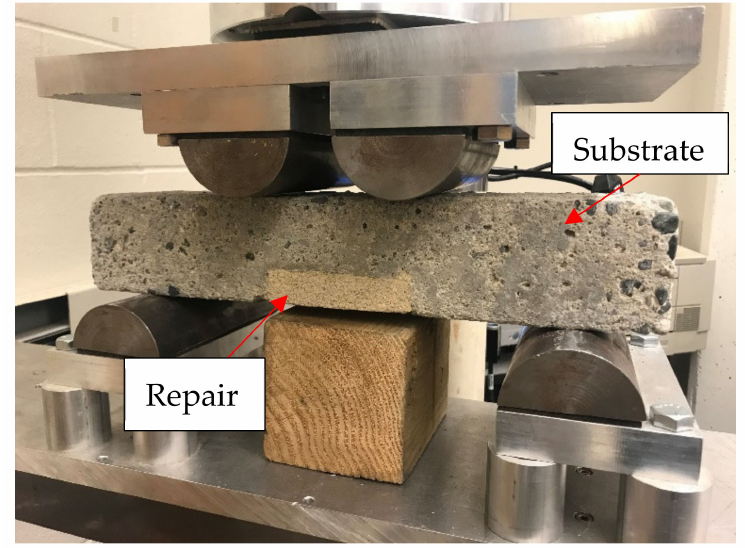
Figure 5. Test setup for cyclic